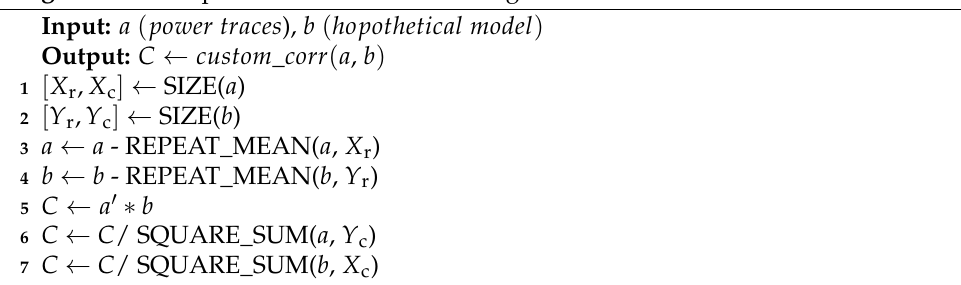
Algorithm 1: Proposed custom correlation